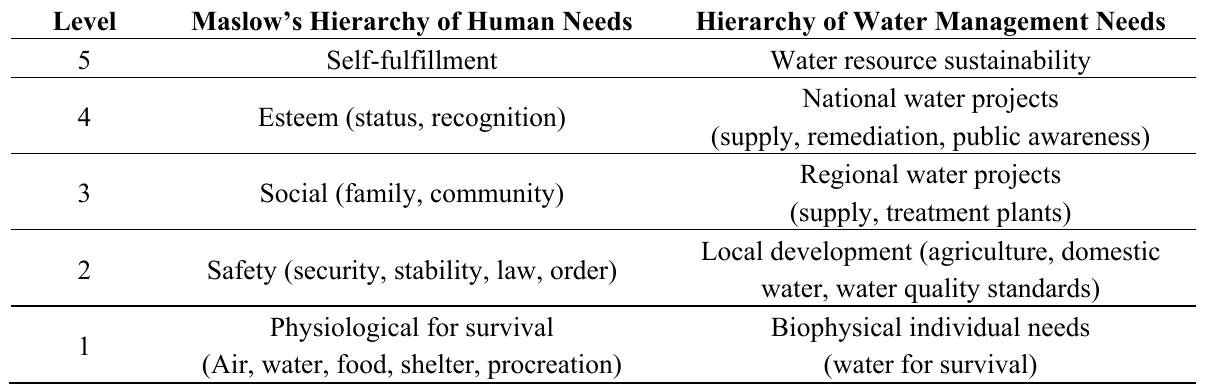
Table 1. Comparison of Maslow’s hierarchy of human needs and the hierarchy of water management needs. Adapted from Melloul and Collin